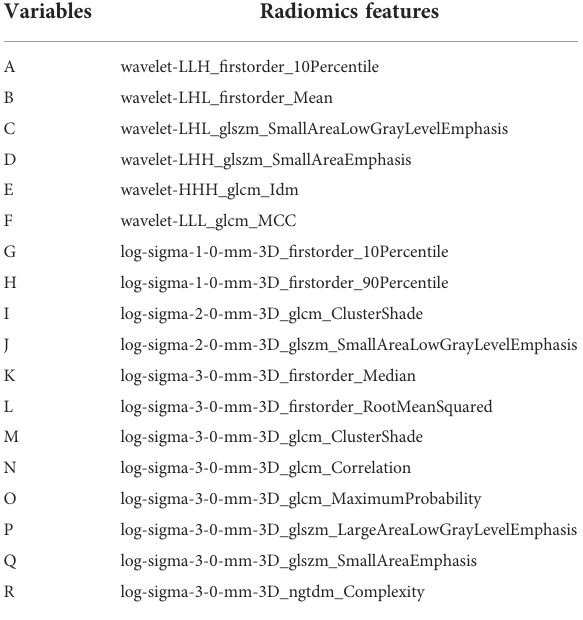
TABLE 3 Radiomics features selected from T2WI